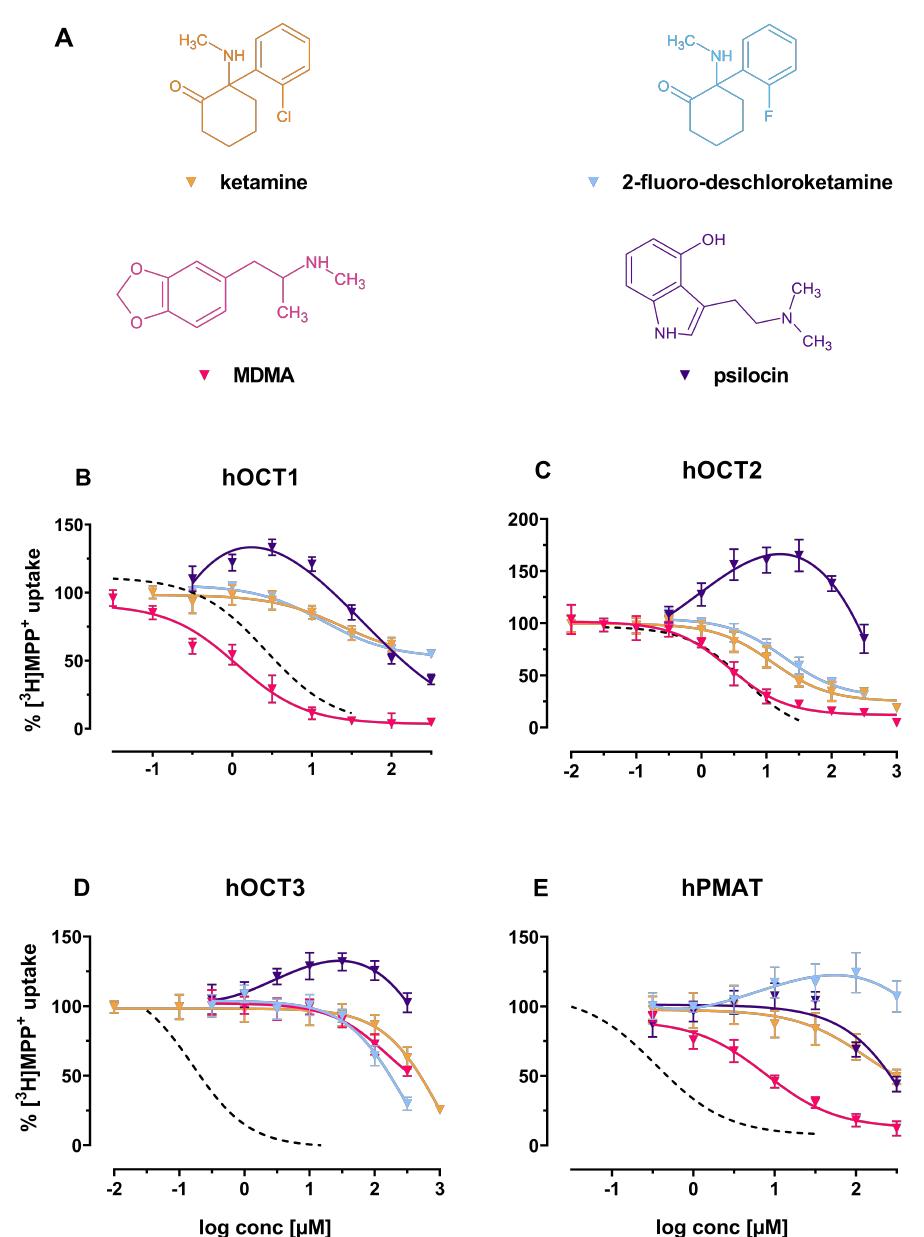
Figure 5. ( A ) Chemical structures of the herein investigated new therapeutics. From left to right: ke- tamine (yellow), 2-fluoro-deschloroketamine (blue; non-therapeutic derivative of ketamine), MDMA (red) and psilocin (violet): ( B – E ): Effects of the above-mentioned compounds (including decynium-22; dashed line) on ( B ) hOCT1, ( C ) hOCT2, ( D ) hOCT3 and ( E ) hPMAT of uptake of tritiated MPP + in HEK293 cells stably expressing the respective